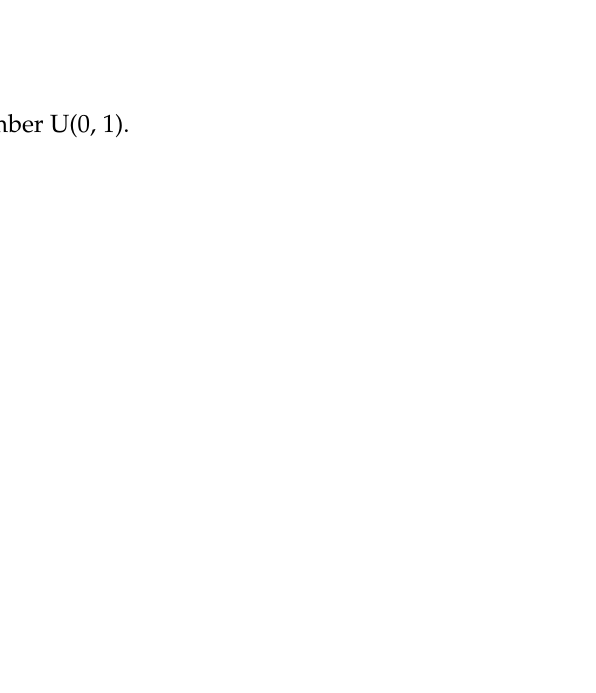
Algorithm 1 Particle swarm optimization